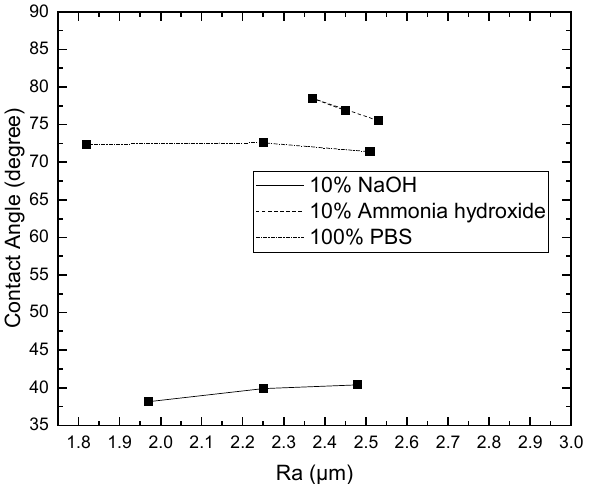
Figure 9. Contact angles of distilled water on Parylene C coated on a substrate with a Shore A hardness of 50 soaked in different solutions.